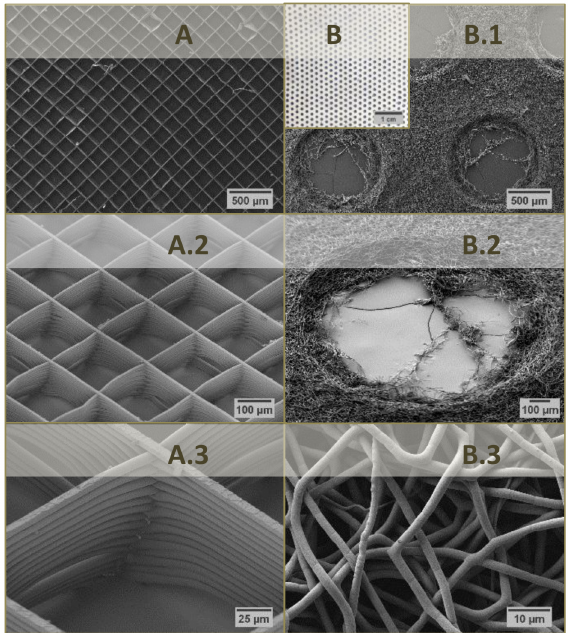
Figure 2. Scanning electron micrographs of MEW fiber mats from PCL with 30 fiber layers and a fiber distance of 200 ( A – A.3 ) as well as scanning electron micrographs of the collector ( B ) and SES fiber mat from PCL with round holes (Ø 1 mm) in alternating rows and a hole distance of 2 mm ( B.1 – B.3